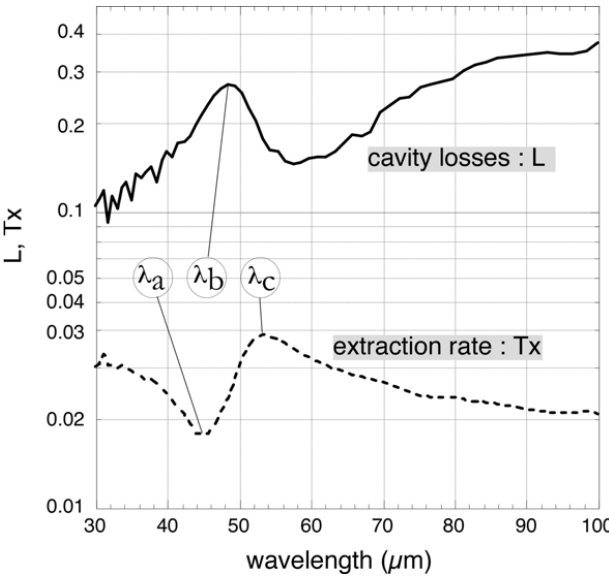
FIG. 5. Simulation of cavity losses L and hole coupling ex- traction rate T X as a function of wavelength, for spherical